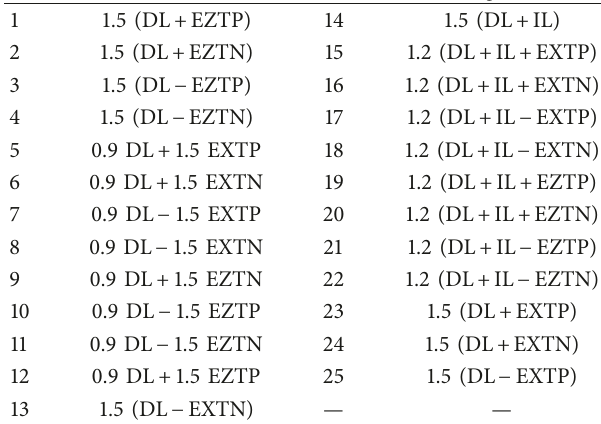
Table 3: Load combinations used for